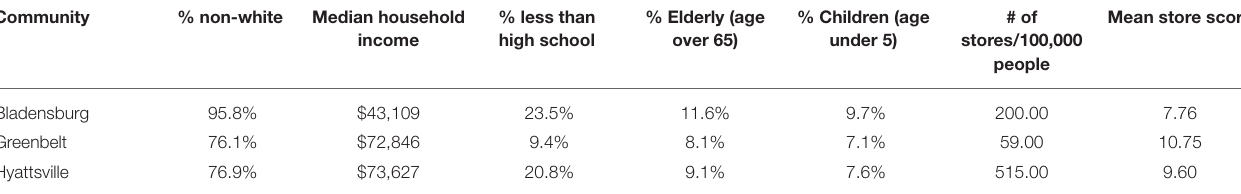
TABLE 2 | Sociodemographic composition and store statistics of study communities. Community